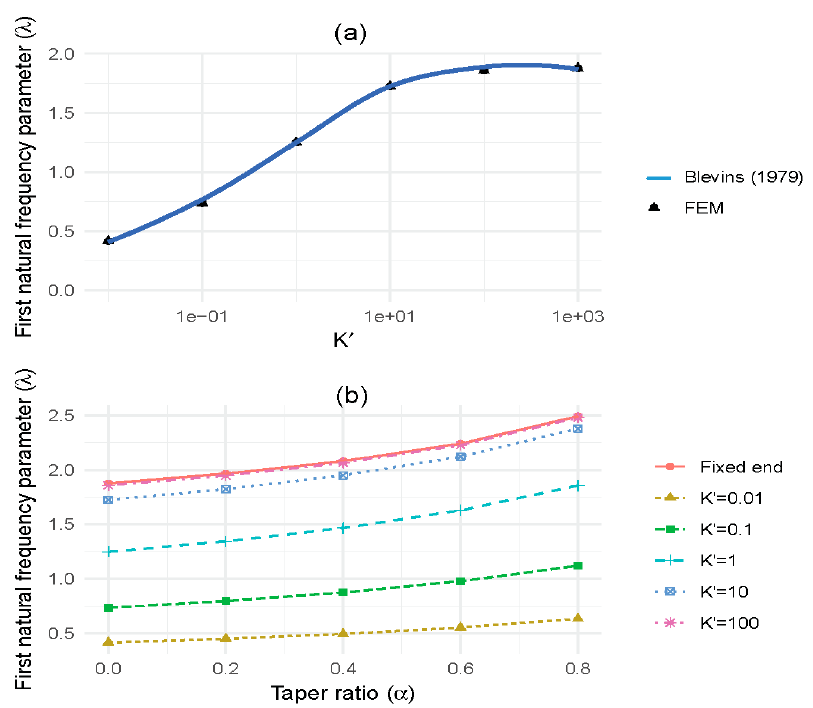
Figure 4. ( a ) Comparison of theoretical and numerical first natural frequency parameter ratio with relative rotational base stiffness, and ( b ) taper ratio versus first natural frequency parameter ratio with varying rotational base stiffness.